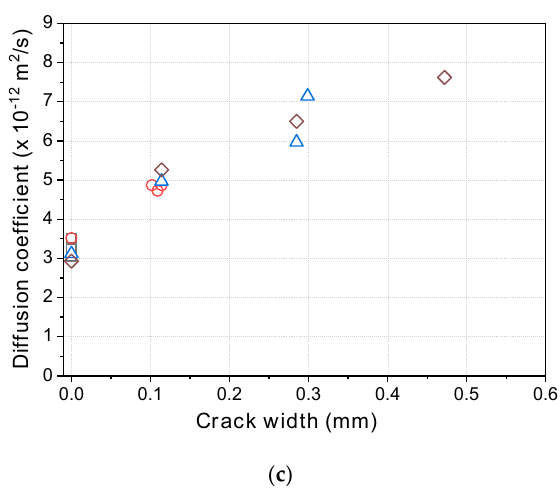
Figure 9. Relationship between diffusion coefficients and crack widths before healing: ( a ) OPC; ( b ) SH-A; ( c ) SH-B.